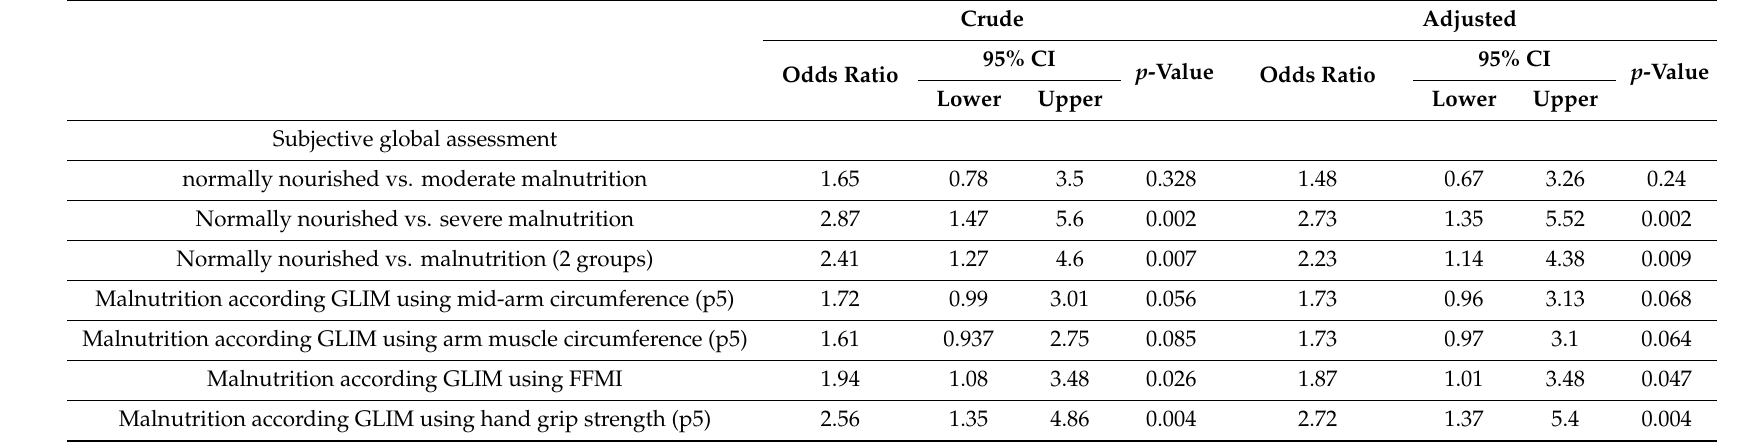
Table 4. Association between malnutrition and mortality (six-month mortality